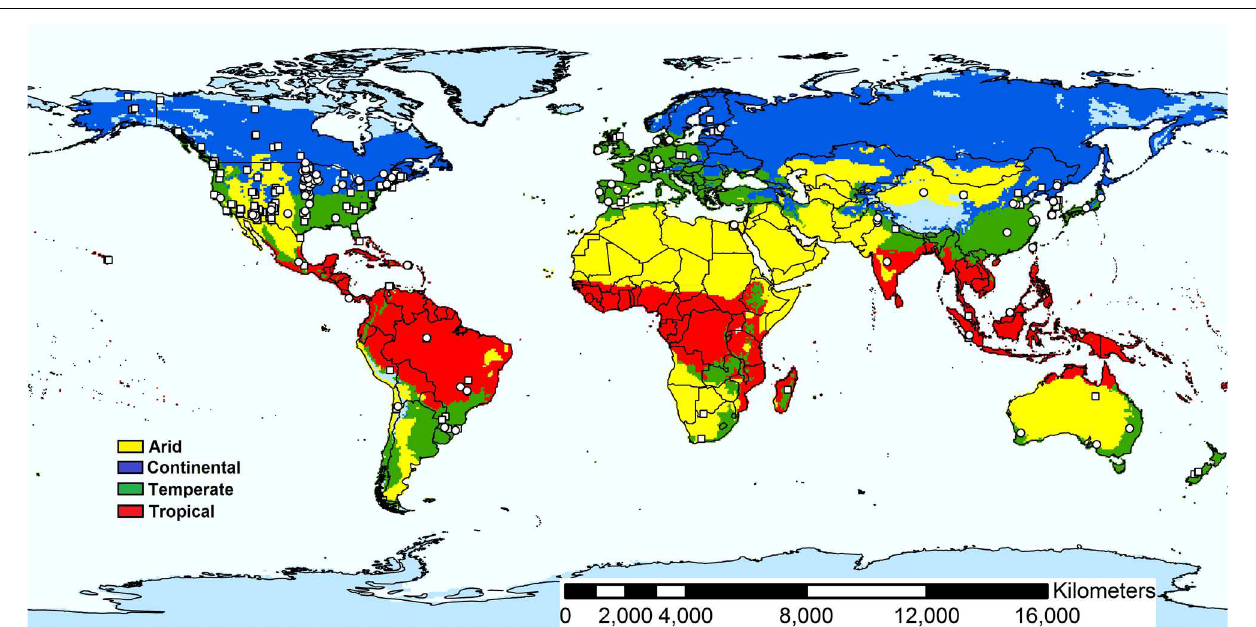
FIGURE 1 | Locations of the soil samples included in this study. Agricultural soil samples ( n = 165) and natural soil samples ( n = 353) are shown as circles and squares, respectively. The sites were selected based on a meta-analysis consisting of both published and unpublished data wherein bacterial diversity and compositions is described based on next generation sequencing techniques (either 454 or Miseq) from both. From those experimental studies that manipulated environmental conditions (e.g., nutrients or climatic conditions) we only used the data from the control treatment (See Material and Methods for more